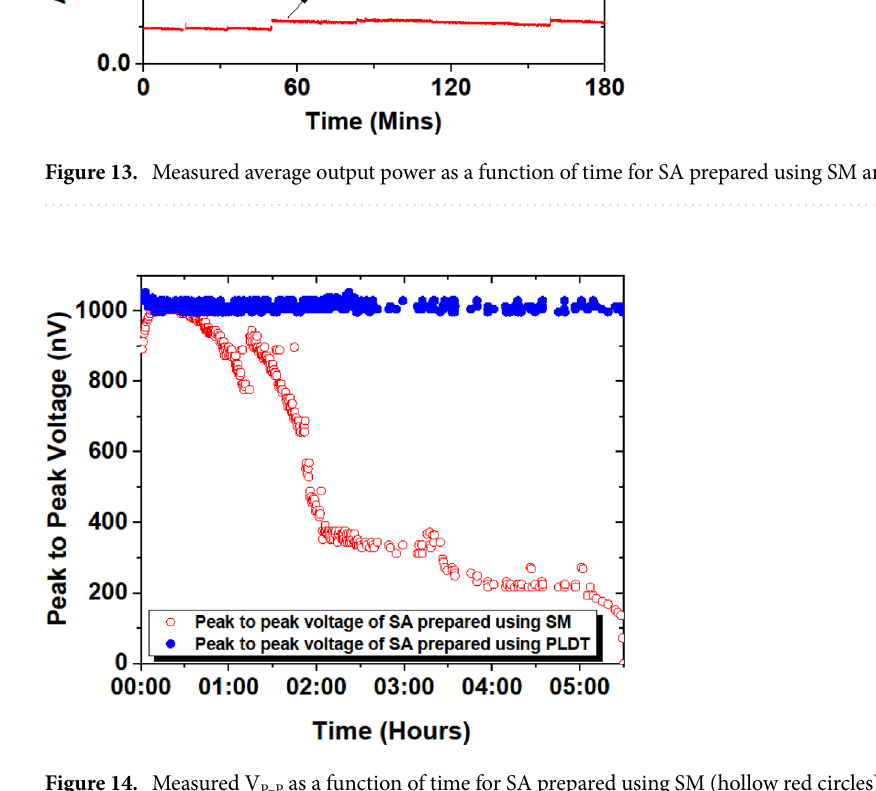
Figure 14. Measured V P–P as a function of time for SA prepared using SM (hollow red circles) and PLDT (solid blue circles).